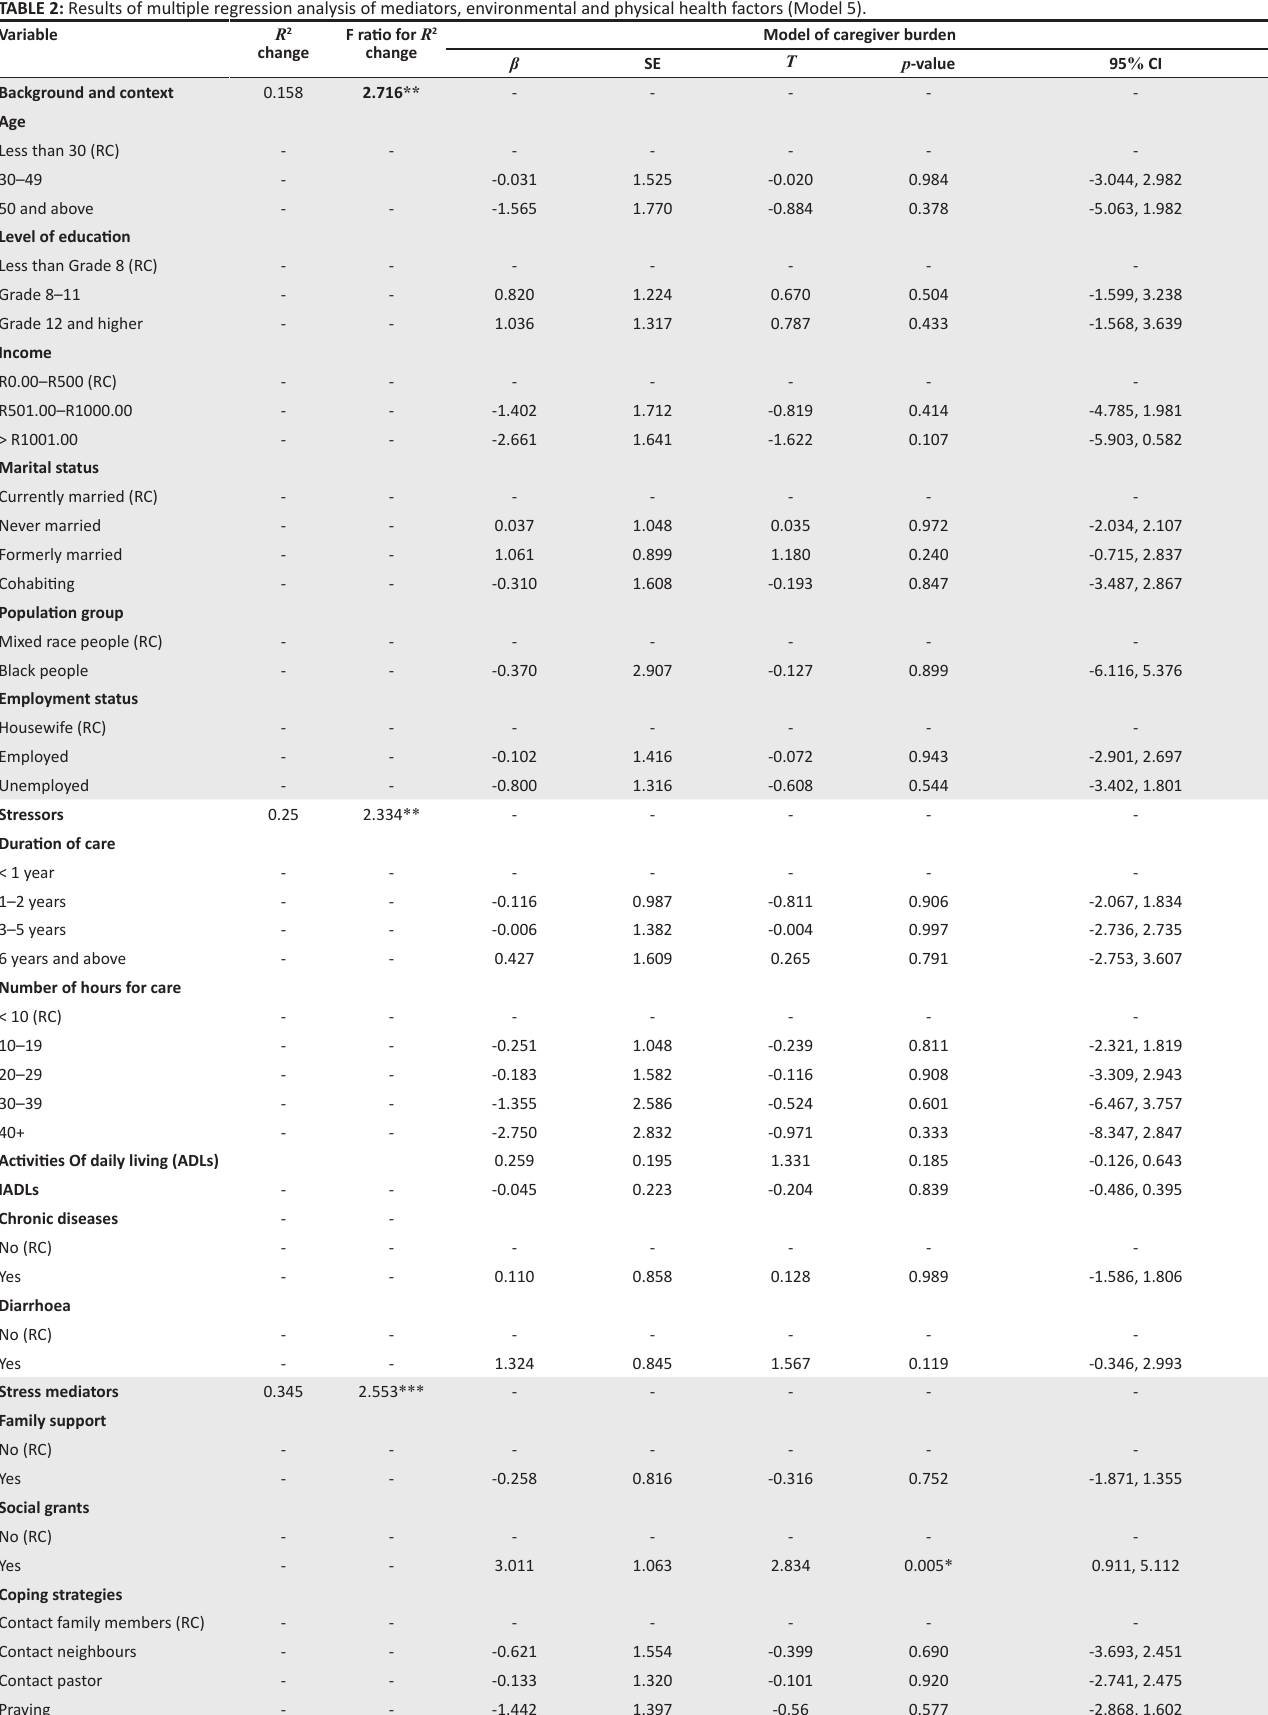
TABLE 2: Results of multiple regression analysis of mediators, environmental and physical health factors (Model 5).